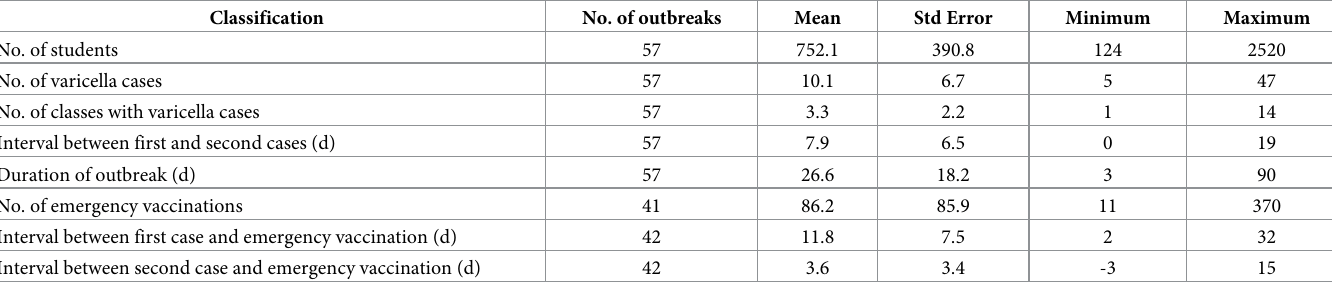
Table 1. Summary of varicella outbreaks in Huangpu District, Shanghai, China from 2011 to 2020.